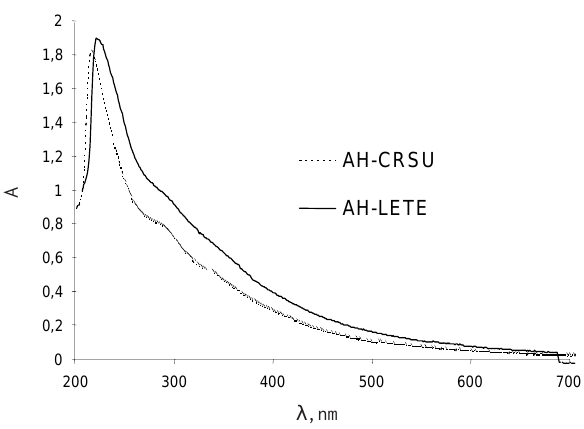
Figura 1. Espectros de absorção na região de ultravioleta (200-350 nm) e visível (350-700 nm) dos ácidos húmicos extraídos do composto de resíduo domiciliar urbano (AH-CRSU) e de lodo da estação de tratamento de esgoto (AH-LETE).